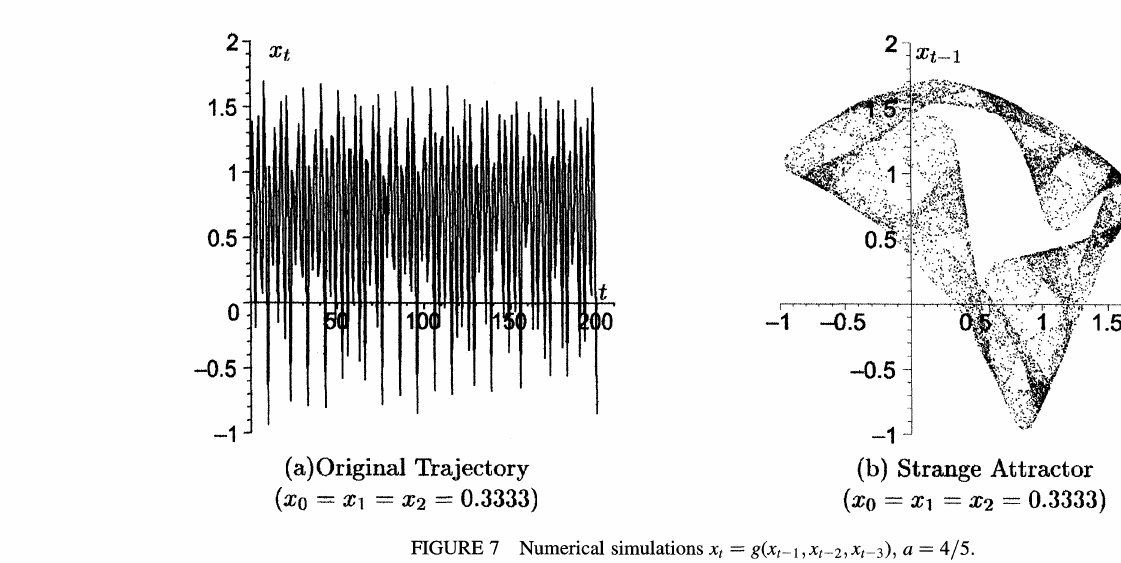
FIGURE 7 Numerical simulations